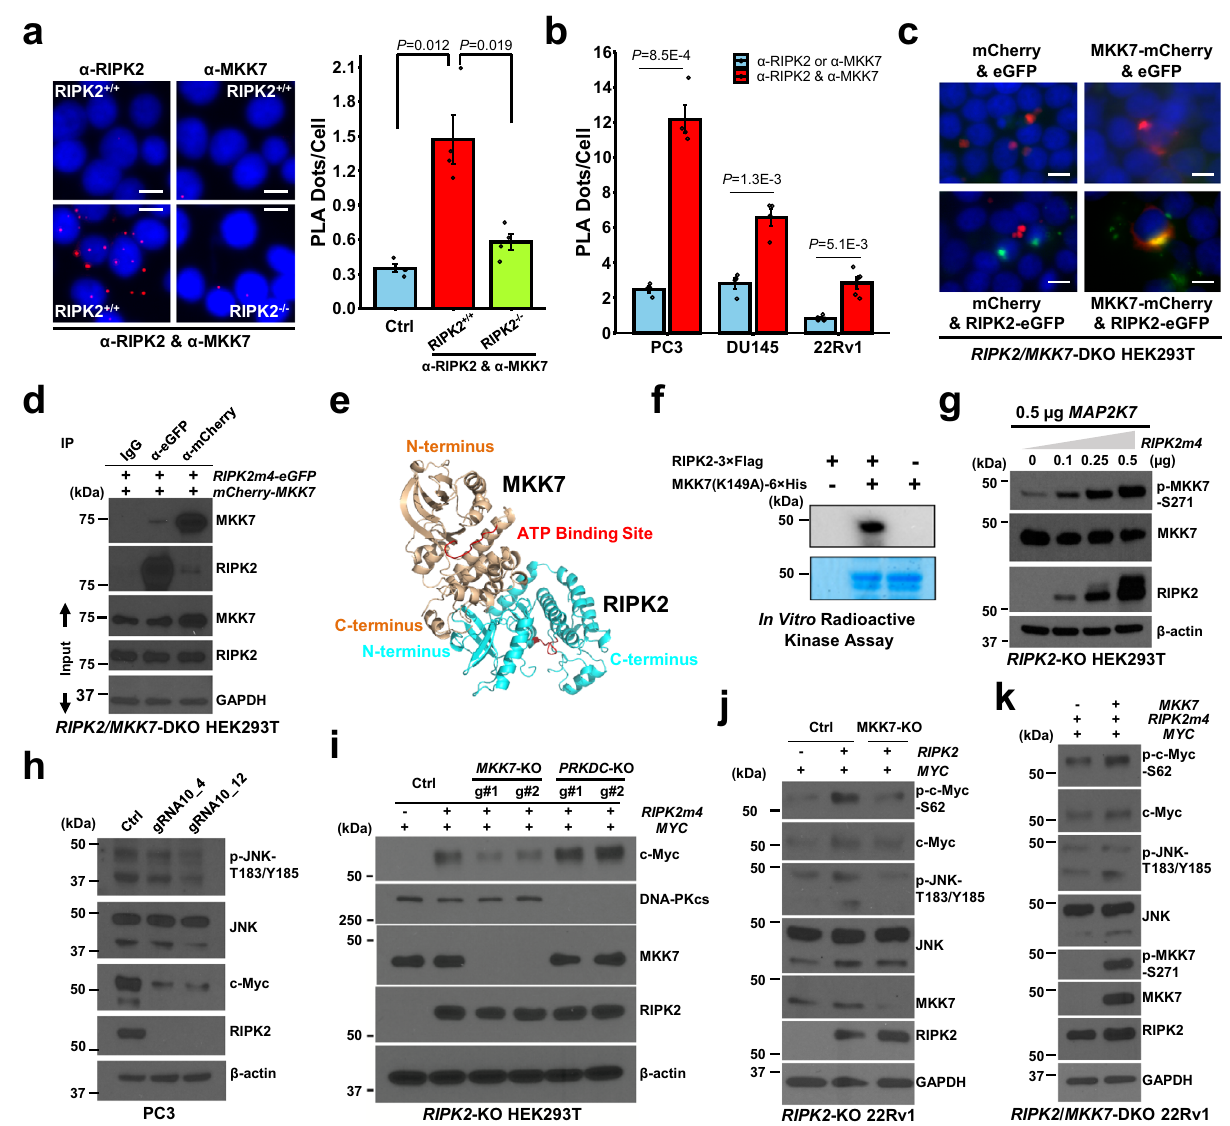
Fig. 6 MKK7 is a major mediator of RIPK2 phosphorylation of c-Myc-S62. a Representative images (left) and quanti fi cation (right) of PLA detecting the association of endogenous RIPK2 and MKK7 in HEK293T cells ( n = 4 biologically independent samples per group). Scale bars, 10 μ m. α -: anti-. b Bar plot of PLA detecting the association of endogenous RIPK2 and MKK7 in parental PC cells ( n = 4 biologically independent samples per group). c Representative images of fl uorescence colocalization of RIPK2 and MKK7 ectopically expressed in RIPK2 / MKK7 -DKO HEK293T cells. Scale bars, 10 μ m. eGFP: enhanced green fl uorescent protein. d Representative images of Co-IP analysis detecting the association of RIPK2 and MKK7 ectopically expressed in RIPK2 / MKK7 - DKO HEK293T cells. e Three-dimensional structural model of direct RIPK2 and MKK7 association in ribbon representation. f Representative images of radioactive in vitro RIPK2 kinase assay detecting RIPK2 phosphorylation of MKK7, using kinase-dead (K149A) MKK7 as substrate. The upper and lower panels show representative autoradiography and Coomassie blue-stained gel images, respectively. g – k Representative immunoblots of the indicated proteins in total lysates of g RIPK2 -KO HEK293T cells transiently transfected with the indicated amounts of RIPK2m4 plasmid, with 0.5 µ g MKK7 being co- transfected to enable reliable quanti fi cation of p-MKK7, h control or RIPK2 -KO PC3 cells, i RIPK2 -KO HEK293T cells under the indicated conditions (g#1 and g#2: two independent gRNAs for gene knockout), j RIPK2 -KO 22Rv1 cells under the indicated conditions, and k RIPK2 / MKK7 -DKO 22Rv1 cells under the indicated conditions. Nominal p- values were determined by unpaired two-tailed Student ’ s t -test ( a , b ). Data are shown as mean ± SEM ( a , b ). Experiments were repeated three times independently with similar results ( c , d , f – k